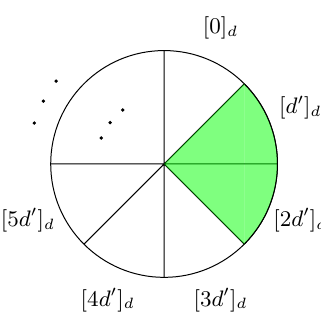
Figure 1 . Pictorial representation of rank- 1 matrix factorizations (3.12). Disk segments labelled by [ id 0 ] correspond to linear matrix factorizations, i.e. r = 1 with the respective charge label d [ a ] = [ id 0 ] . Unions of r neighboring segments correspond to matrix factorizations with r > 1 . For d d instance the union of the two green segments above corresponds to the matrix factorization (3.12) with r = 2 and [ a ] = [ d 0 ] d d